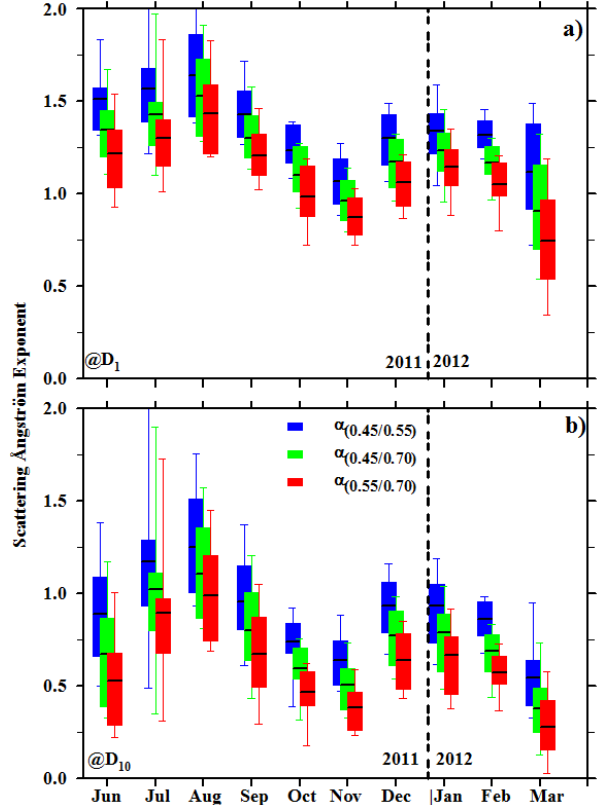
Figure 3. Same as in Fig. 2 but for the back-scattering Ångström